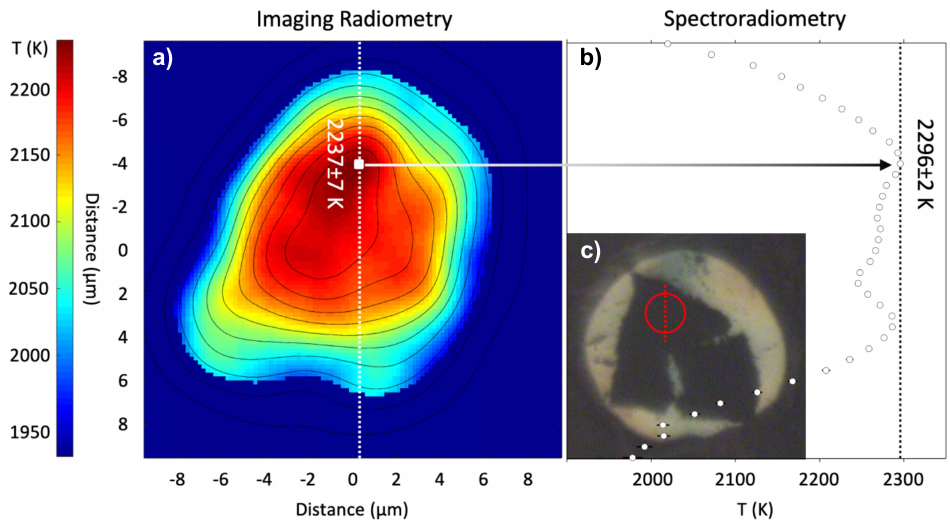
Figure 6. Comparison between 1-D spectroradiometry and 2-D imaging radiometry for temperature measurement on a sample of FeS 2 (pyrite) at 54 GPa in the LH-DAC. ( a ) Imaging radiometry temperature map generated from a four-color system and processed using the MIRRORS software [129]. Contours indicate light intensity in 10% intervals relative to the brightest pixel. ( b ) Corresponding spectroradiometric temperature cross-section collected within 1 sec of the temperature map at the same nominal location (the white dotted line in ( a )). Note the similarity in shape and peak temperature, denoted by the white square in ( a ) and the black dotted line in ( b ). ( c ) A photomicrograph of the sample before heating, with the 25-micron diameter heated spot indicated by the red circle. The red dotted line indicates the location of the spectroradiometric measurement presented in ( b